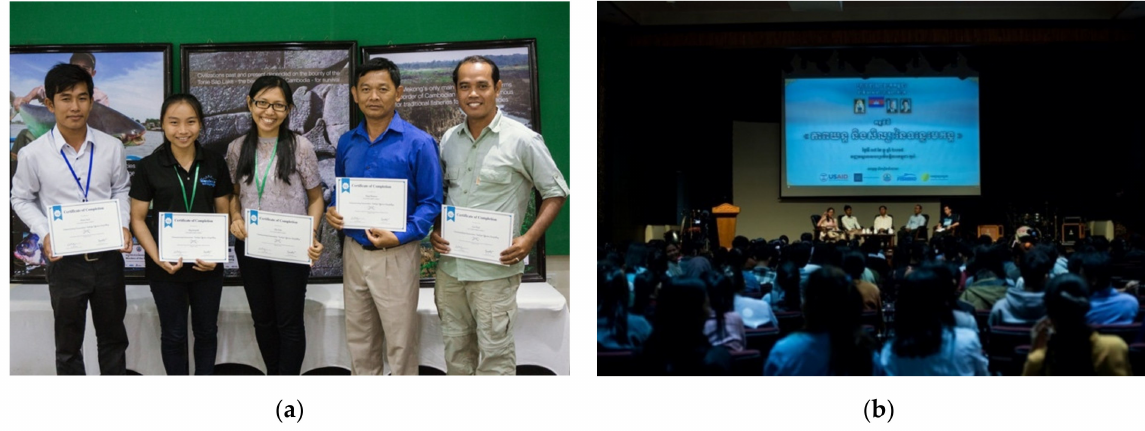
Figure 6. Honorees of the WOM Mekong Conservation Heroes program: ( a ) Conservation Heroes after completing a training in conservation storytelling; ( b ) Mekong Conservation Heroes participating in a panel discussion during a WOM conservation outreach festival in Phnom